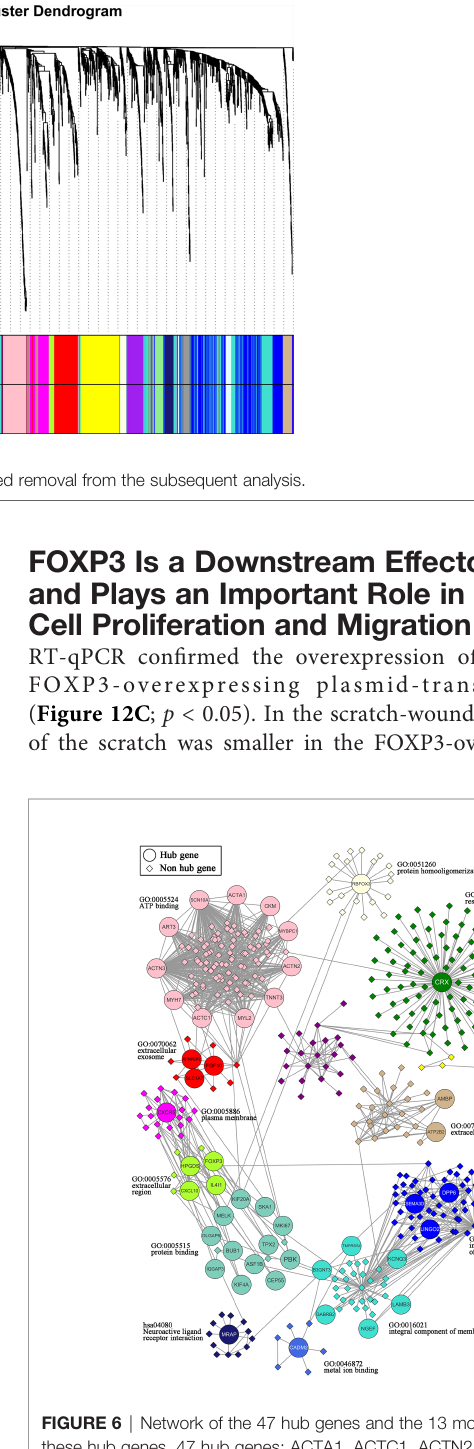
FIGURE 5 | Heatmap of module-trait relationships. Each row corresponds to a module, and each column corresponds to a trait. The progressively increase in blue and red saturation indicated a high Pearson ’ s correlation coef fi cient. The numbers in the squares indicate Pearson ’ s correlation coef fi cients.